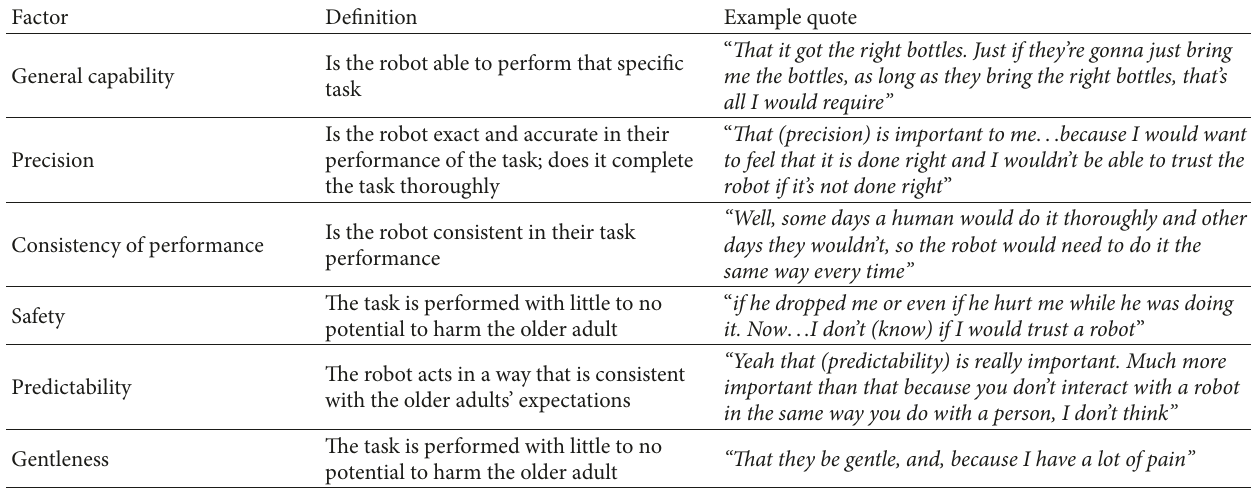
Table 5: Professional skills: definitions and examples of factors.